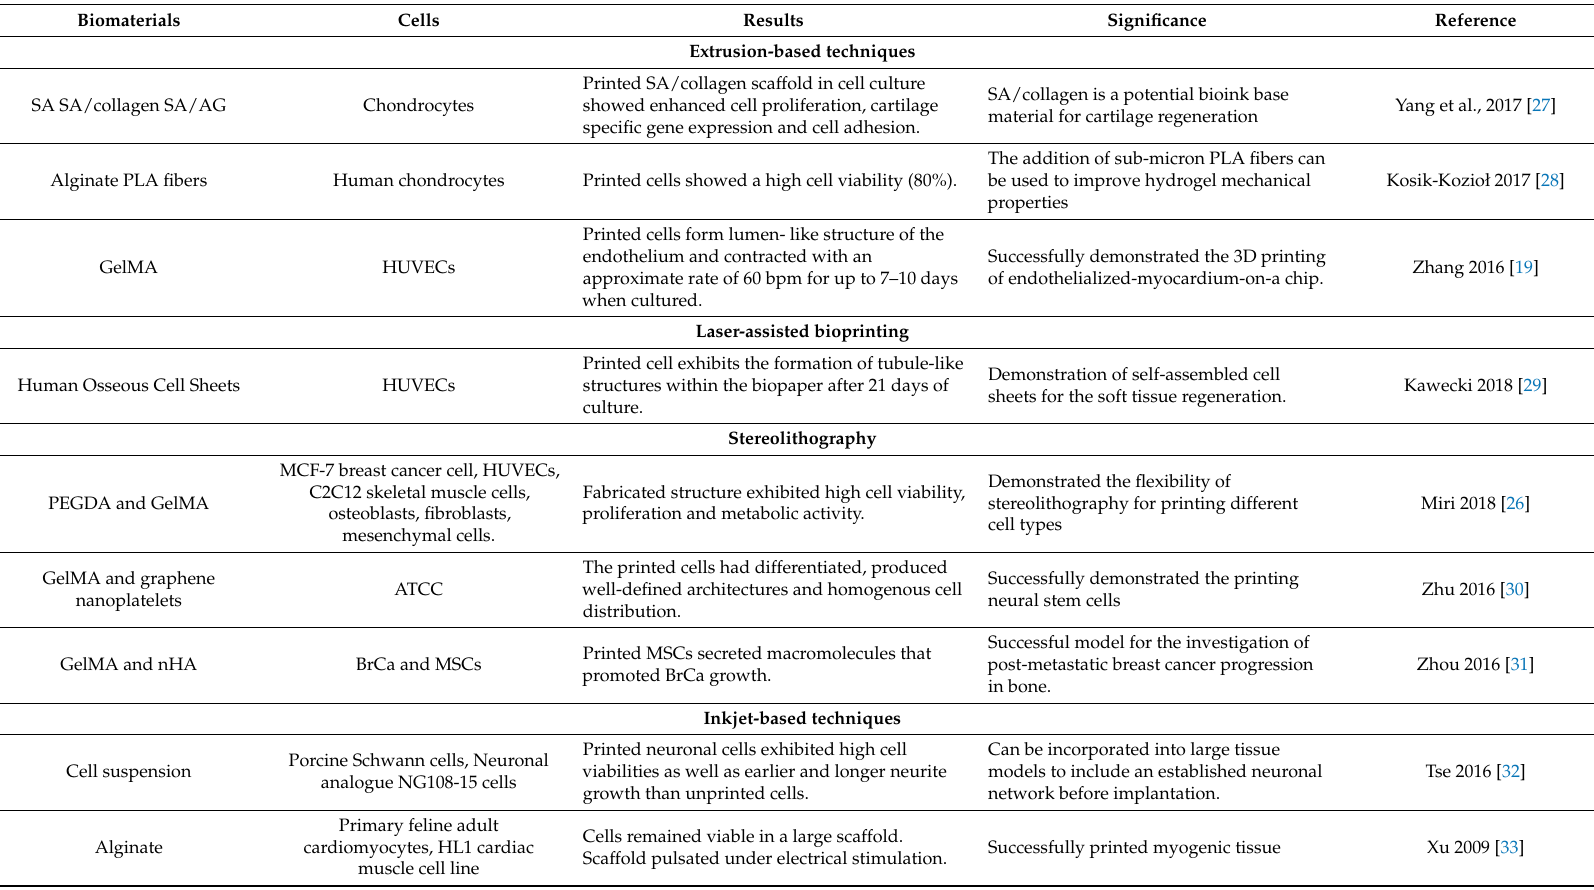
Table 1. Recent in vitro studies. AG—Agarose, SA—Sodium alginate, PLA—Polylactide fibers, GelMA—gelatin methacryloyl, HUVECs—Human umbilical vein endothelial cells, PEGDA—poly(ethylene glycol) diacrylate, ATCC—Mouse neural stem cell lines, BrCa—breast cancer cells, MSCs—marrow mesenchymal stem